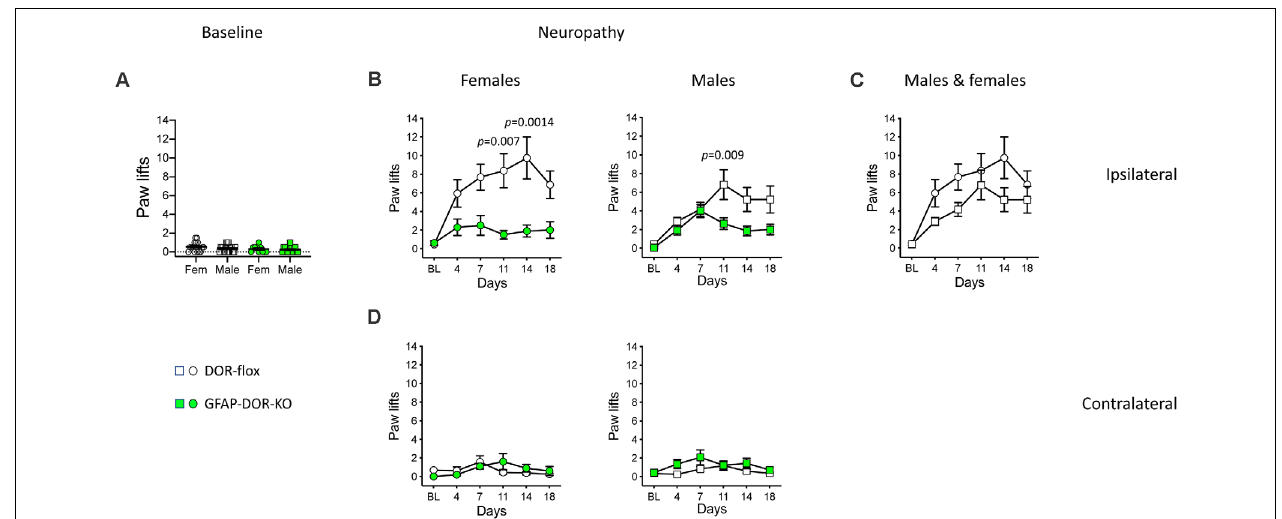
FIGURE 4 | Cold neuropathic allodynia was attenuated in GFAP-DOR-KO mice. (A) Baseline paw responses on the cold plate in GFAP-DOR-KO and DOR-flox mice. GFAP-DOR-KO mice reacted comparably to DOR-flox control mice (Two-way ANOVA). (B) Paw responses at the ipsilateral side on the cold plate following pSNL. Cold allodynia was abolished in DOR-GFAP-KO females, with genotype differences on individual days 11 and 14. Cold allodynia was reduced in GFAP-DOR-KO males with a genotype difference on day 11 time-point. (C) The comparison of cold allodynia in DOR-flox females and males indicated no sex difference. (D) There was a modest cold allodynia at the contralateral side in males but not females, which did not reach significance at any individual time points. n = 16 DOR-flox females, n = 10 GFAP-DOR-KO females, n = 17 DOR-flox males, n = 14 GFAP-DOR-KO males. Two-way repeated measures ANOVA followed by Sidak’s multiple comparison test. Data are expressed as mean ± SEM. See also Supplementary Table 4 for